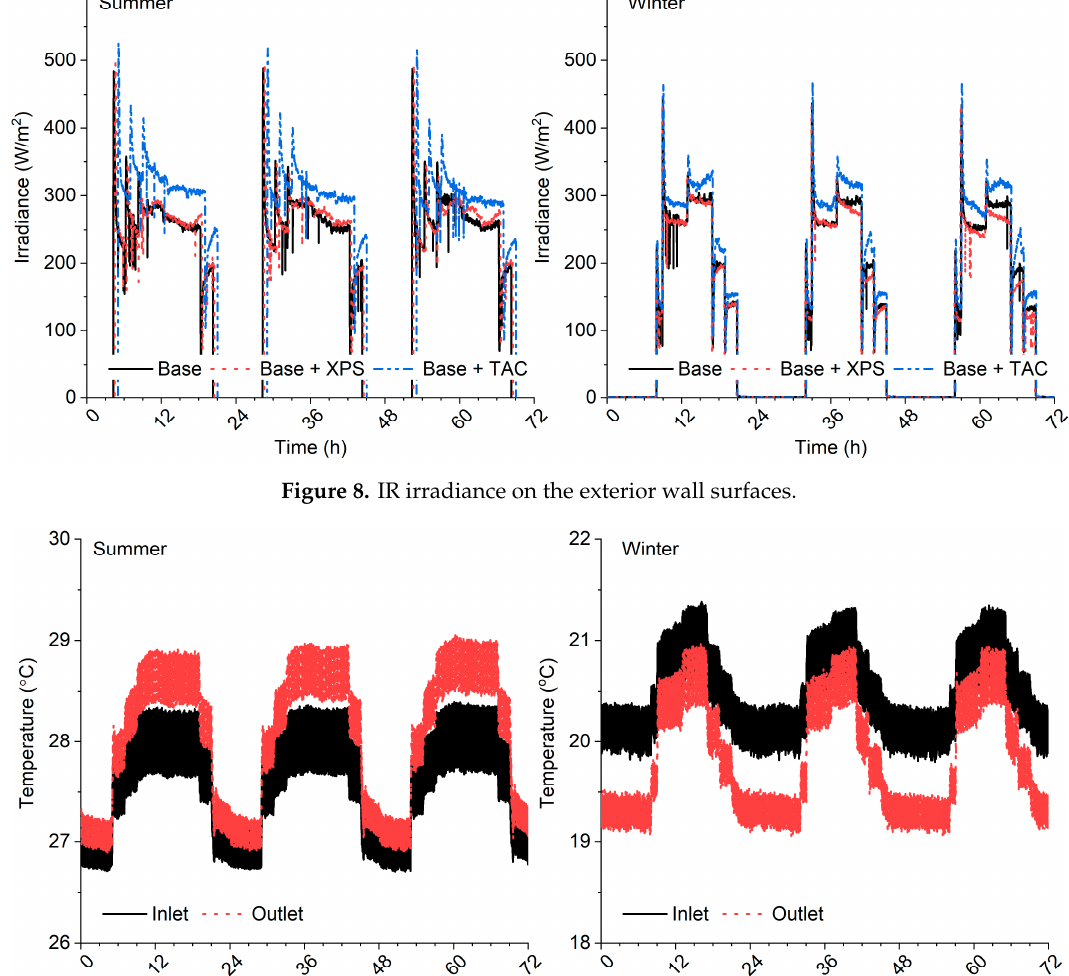
Figure 9. Average inlet and outlet water temperatures in the Cu tubes for the “Base + TAC” tests.